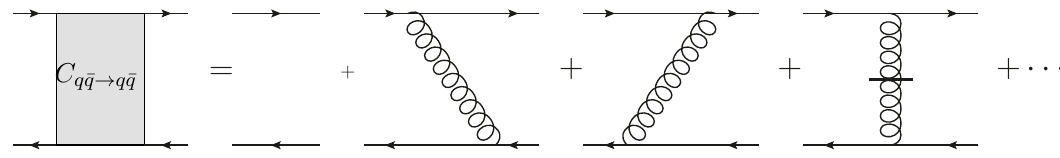
Figure 1. Perturbative corrections to the meson light-front wave function Ψ q ¯ q